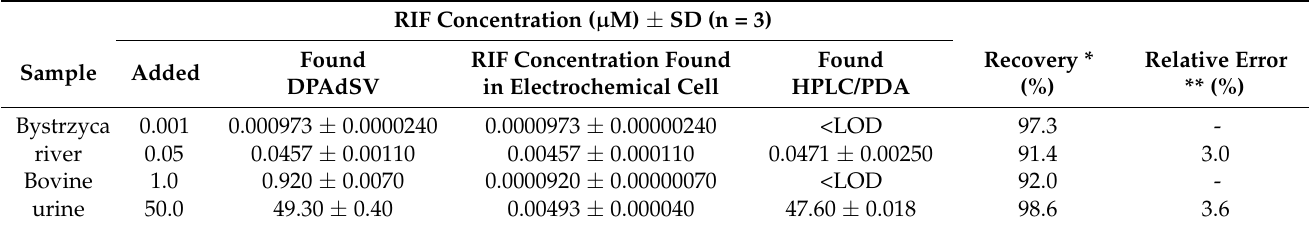
Table 2. The results of RIF determination in river water and bovine urine samples.